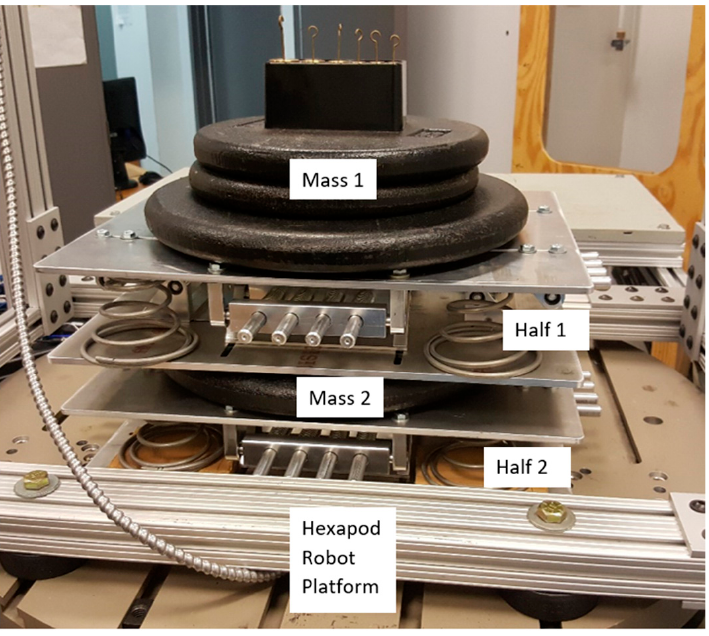
Figure 4. 2DOF prototype QZS system, placed on the six degree of freedom Mikrolar robot. Two triaxial accelerometers (Dalimar ceramic shear ICP ® accel PCB model 356A17